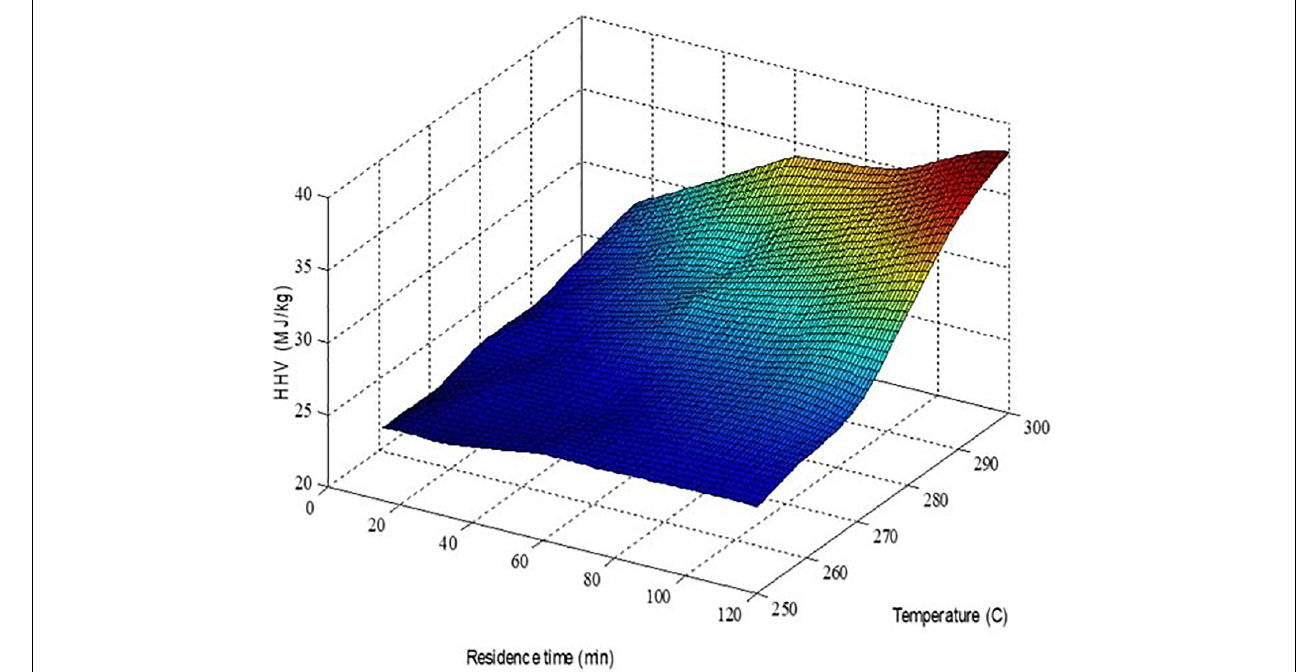
FIGURE 2 | Calculated torrefied biomass HHVs as a function of torrefaction temperature and residence